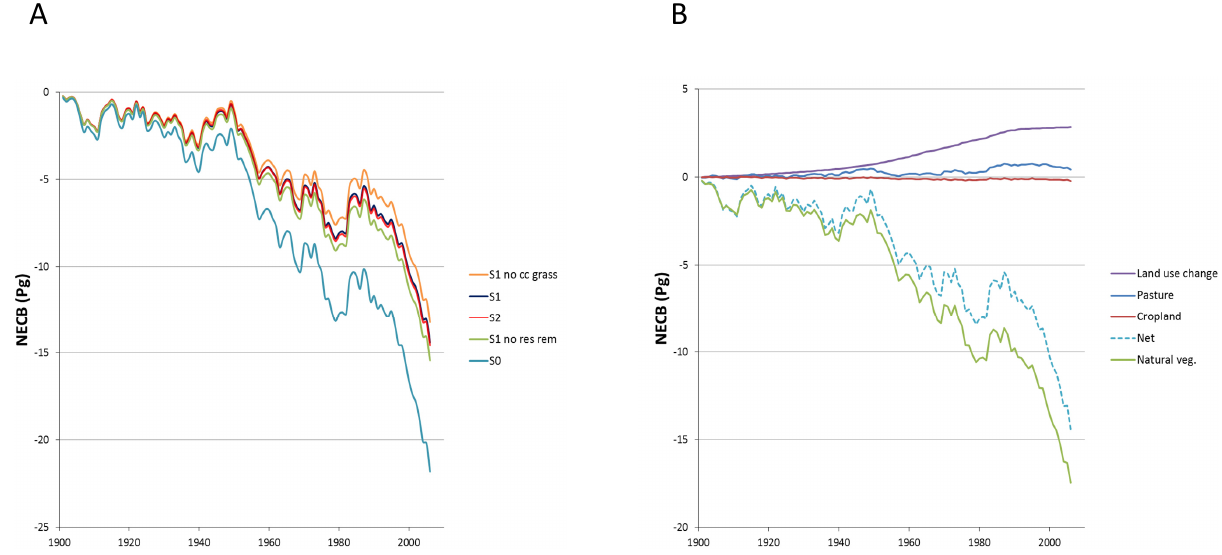
Fig. 10. (A) Modelled cumulative net ecosystem carbon balance (NECB) for the African continent in simulations with different land use and crop management settings: S0, potential natural vegetation (PNV) only (“S0”); S1, PNV plus explicit representations of cropland and pasture, including land use change, with standard crop management settings (90% harvest efficiency, 75% crop residue removal, cover crop grass growth and full irrigation of irrigated cropland (“S1”)); S1.8, without crop residue removal (“S1 no res rem”); S1.7, without cover crop grass (“S1 no cc grass”); and S2, PNV plus grassland representing both cropland and pasture, including land use change (“S2”). (B) S1 simulation (“Net”) NECB separated into natural vegetation, pasture and cropland land covers and the land use change component, derived from the harvested carbon of natural vegetation converted into cropland. Positive values represent a flux to the atmosphere.